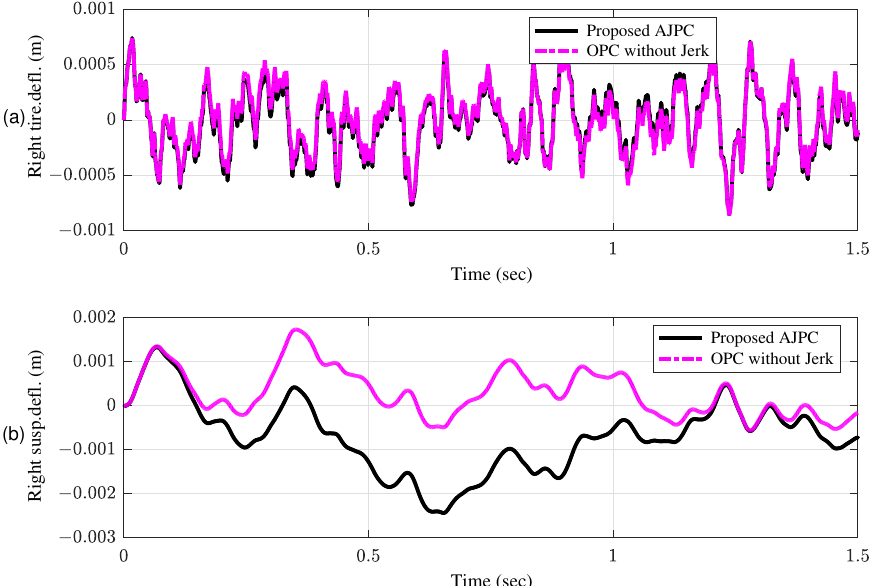
Figure 16. Time domain comparison of tire and suspension deflection between proposed AJPC strategy and OPC strategy without jerk; ( a ) right tire deflection ( b ) right suspension